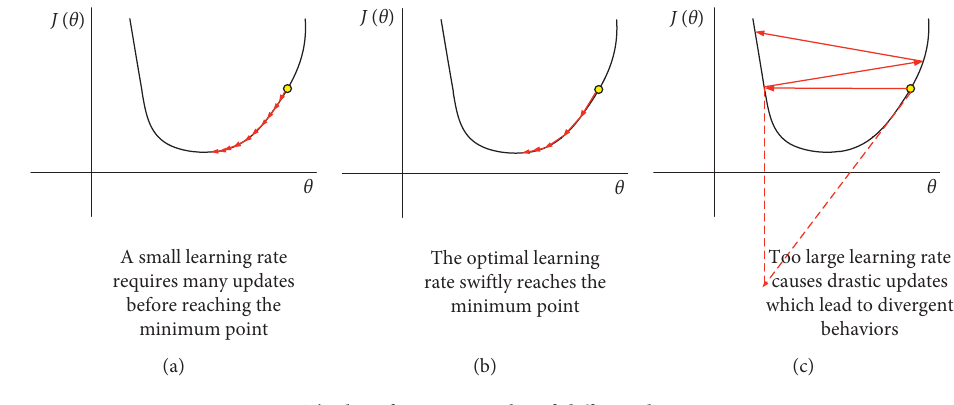
Figure 1: The loss function results of different learning rates. Table 5: Gradient descent functions and parameter description.